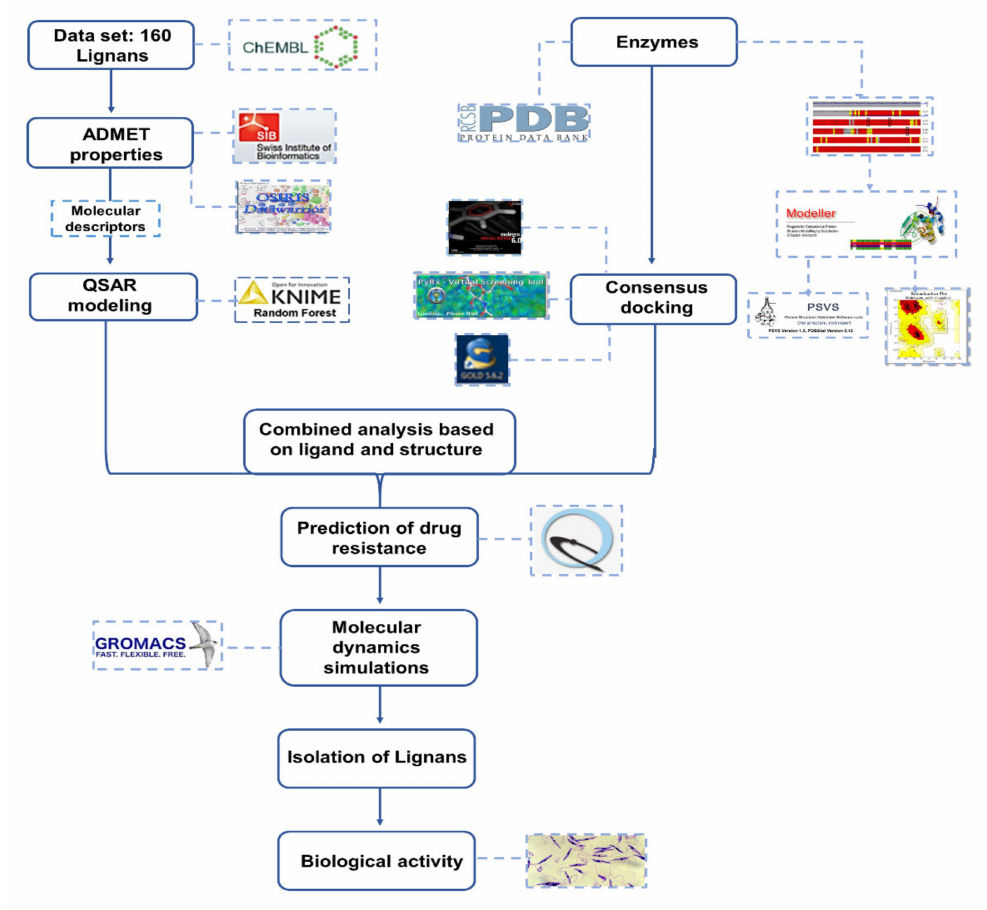
Figure 12. Scheme of all procedures used in this